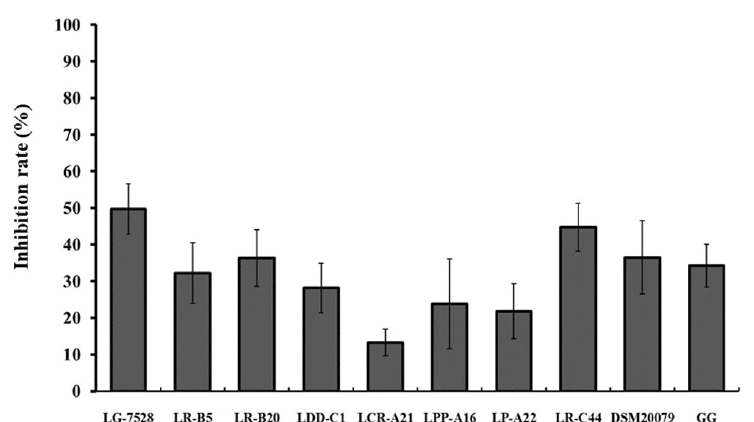
Figure 3. Effect of 1 h pre-incubation with lactobacilli strains on the L. monocytogenes EGDe adhesion to the Caco-2 cells (exclusion). Data represent the mean values ± standard error of the mean (SEM) of three biological and two technical replicates.